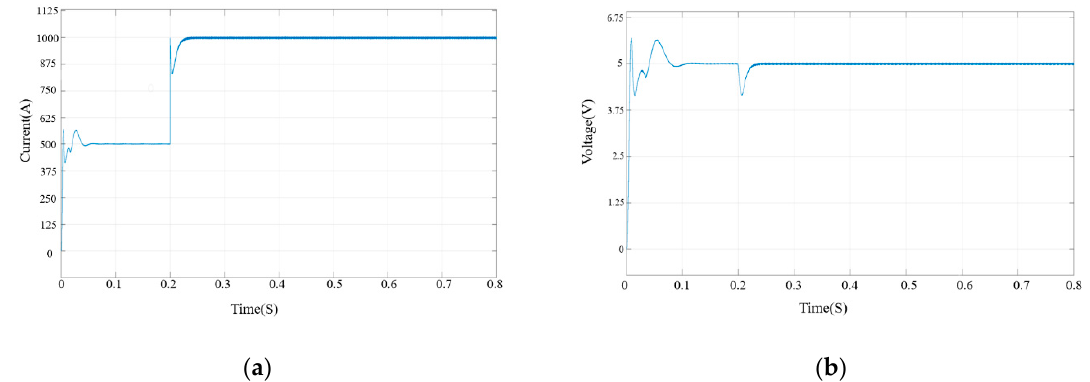
Figure 28. Output simulation results of the three parallel modules: ( a ) current simulation waveform under sudden load change, and ( b ) voltage simulation waveform under sudden load change.